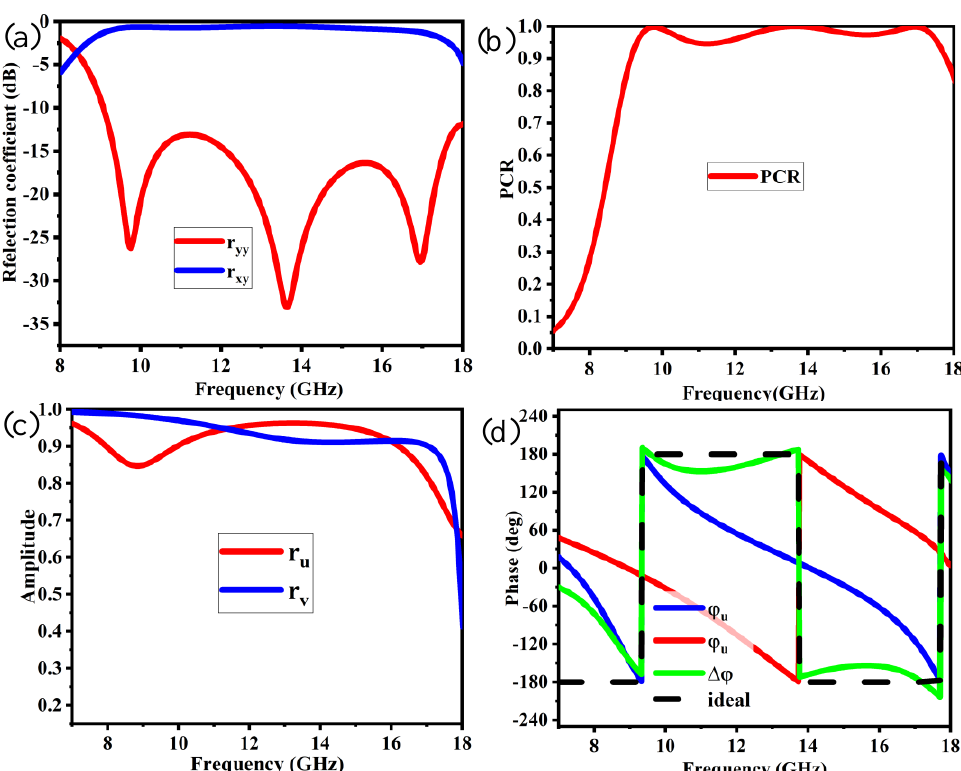
Figure 7. ( a ) Co − and cross − polarization component r yy and r xy ; ( b ) Polarization conversion ratio ( PCR ); ( c ) Magnitude of orthogonal components r u and r v ; ( d ) Phase difference.